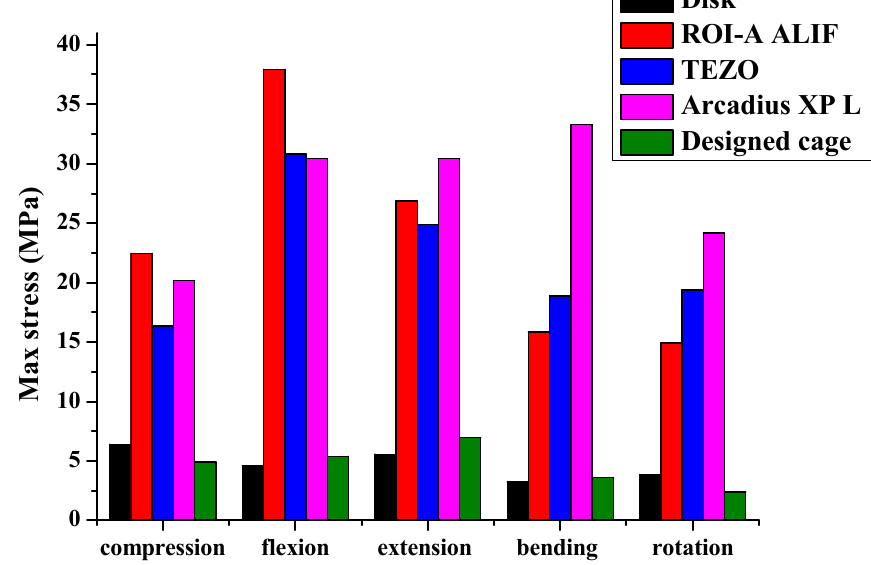
Table 19. The max stress and strain of the disk.